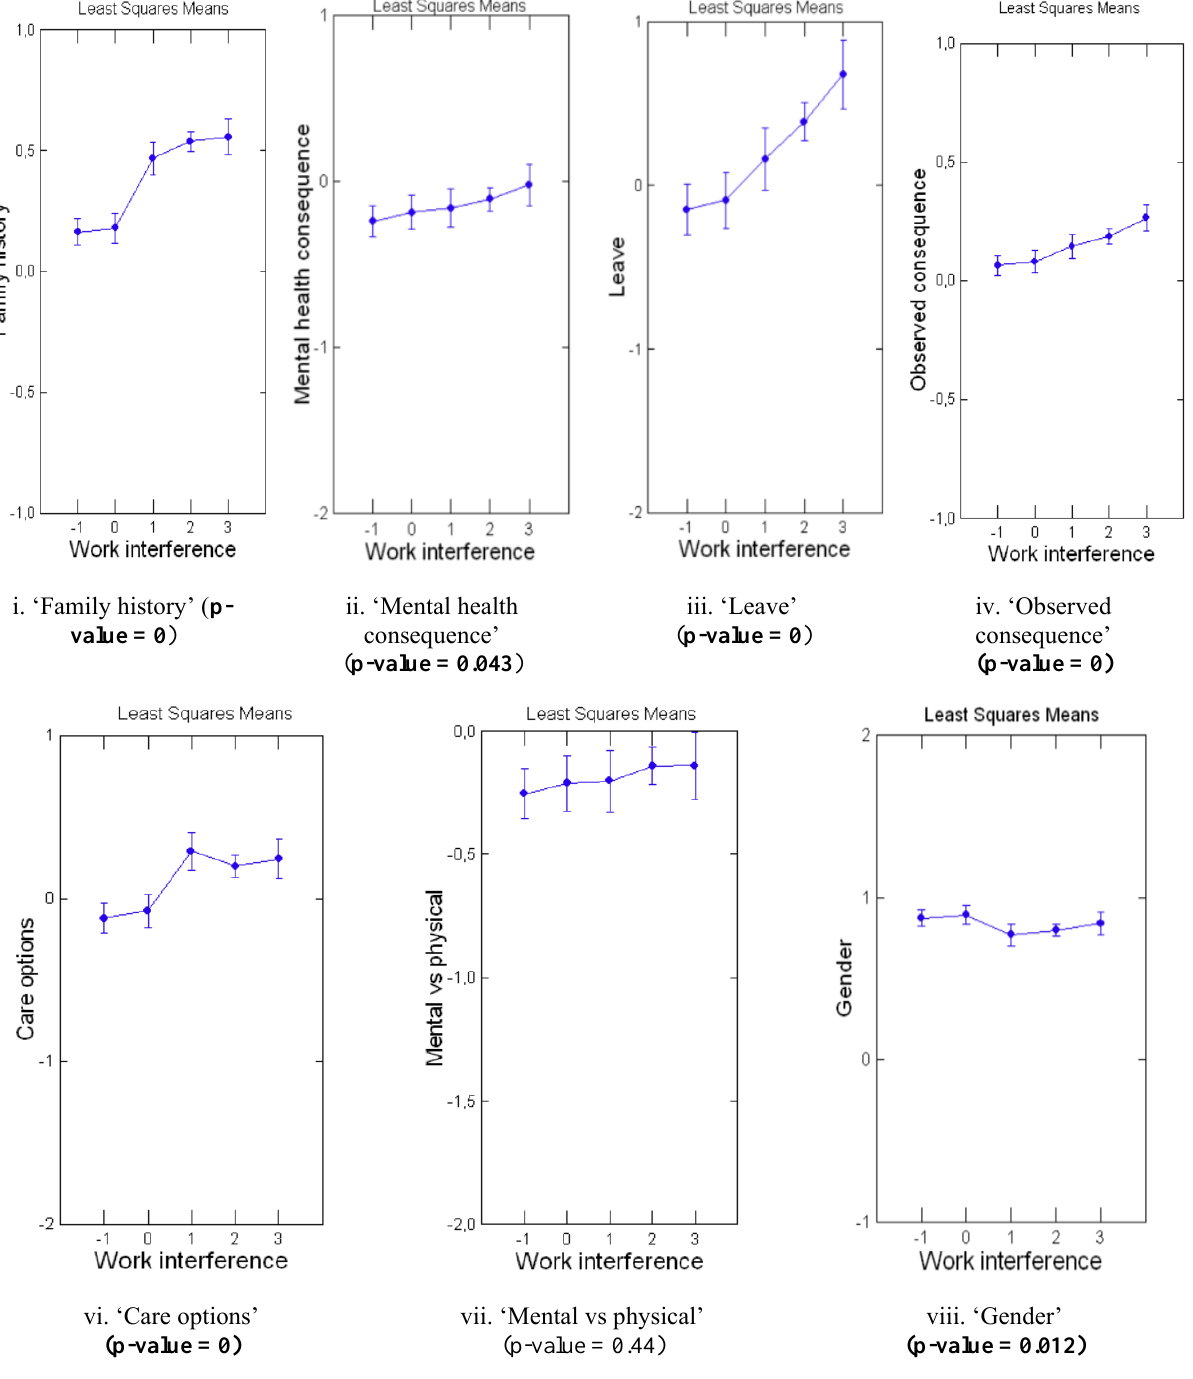
Fig. 5. ANOVA of selected features. Bold represents significantly (p-value<0.05; 95% CI) different group